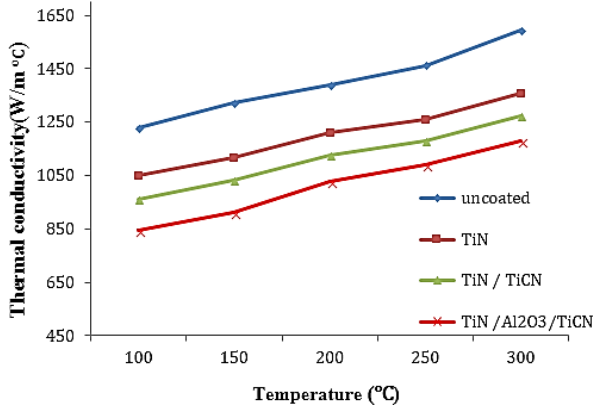
Figure 3: The relationship between the thermal conductivity and the temperature for different tool specimens